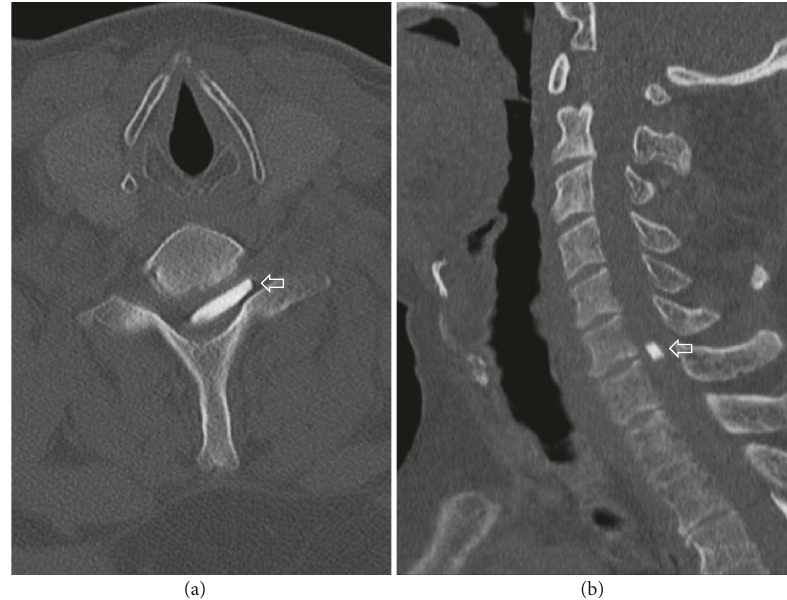
Figure 2: CT of the cervical spine: bone windows, axial (a) and sagittal reconstruction (b) showing a hyperdense oblong lesion at the level of C6-C7 in the left intervertebral foramen and spinal canal (arrows).